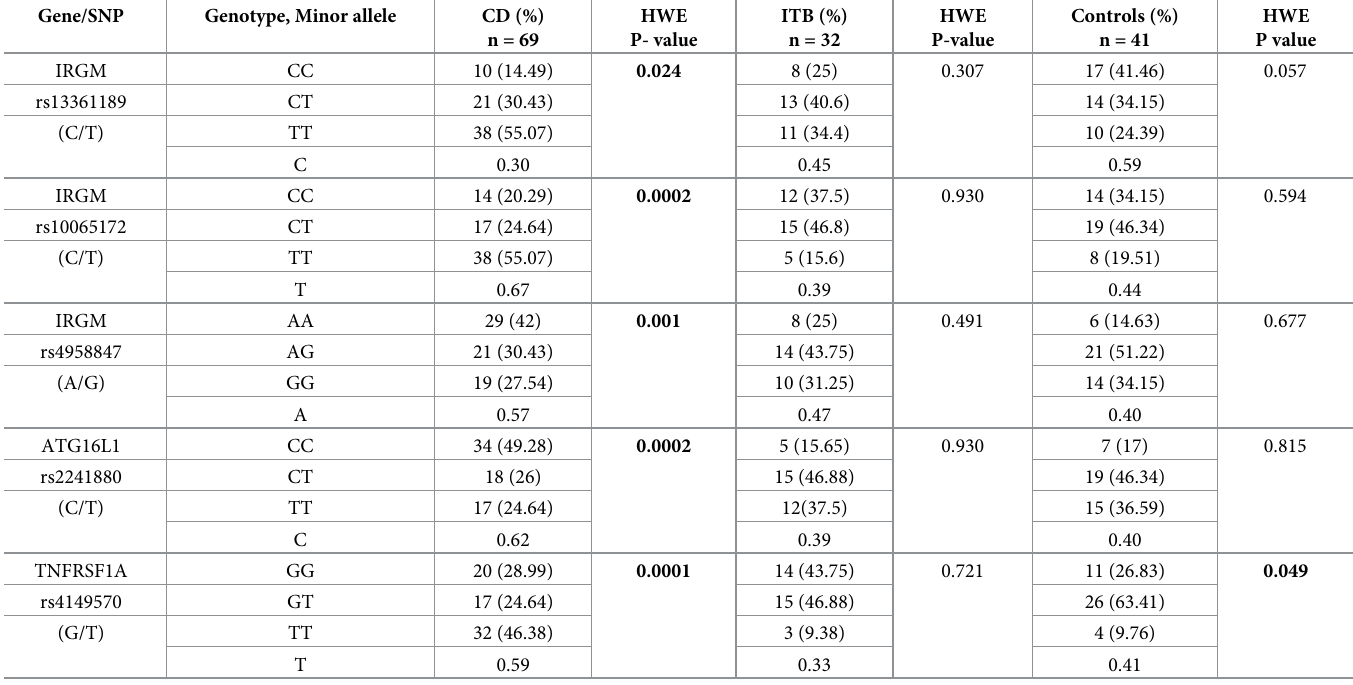
Table 3. Frequency and distribution of SNP allele and genotypes in cases (CD, ITB) and controls. Gene/SNP Genotype, Minor